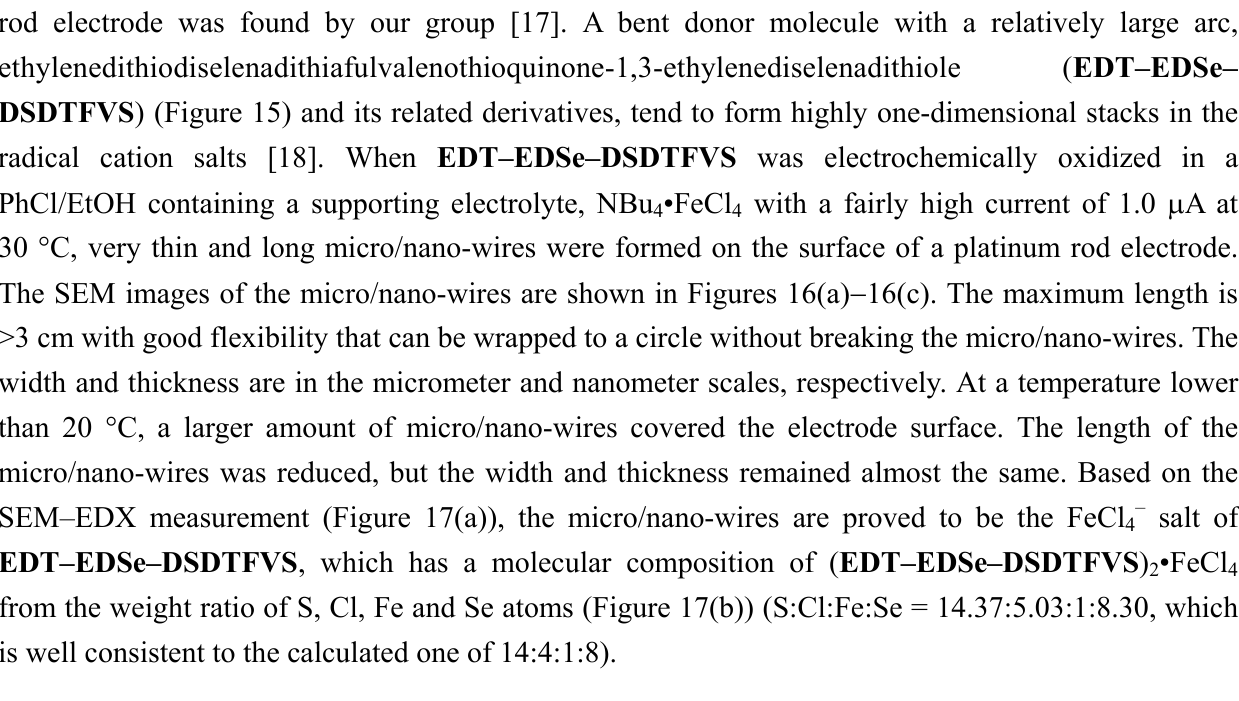
Figure 15. The chemical structure of ethylenedithio-ethylenediseleno- diselenadithiafulvalenothioquinone-1,3-dithiolemethide ( EDT–EDSe–DSDTFVS ).